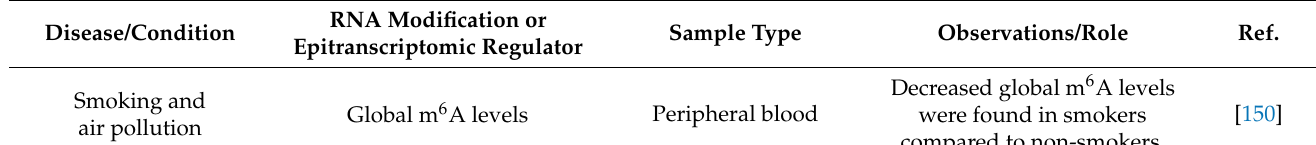
Table 2. Expression of epitranscriptomic regulators and their observed roles in diverse